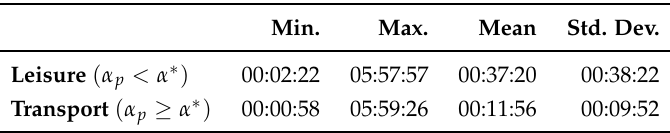
Table 2. Travel Time Statistics.